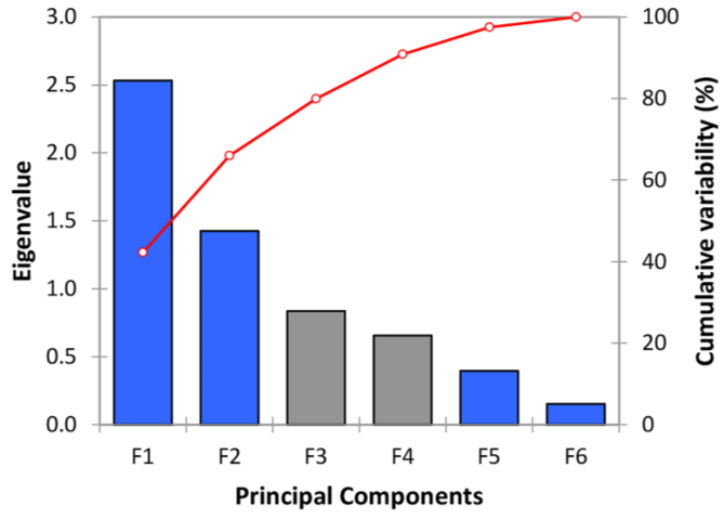
Figure 1. Scree plot for explained eigenvalues and cumulative variability (%) from PCA analysis. In the next step, the matrix of eigenvectors ( a jj ) was generated (Table 6). The eigenvalue indicates the quantity of variability in the direction of its corresponding eigenvector. There- fore, the eigenvector with the largest eigenvalue is the direction with the most variability, and this eigenvector is the first principal component (F1). Table 6. Eigenvectors matrix between the study variables and principal components.